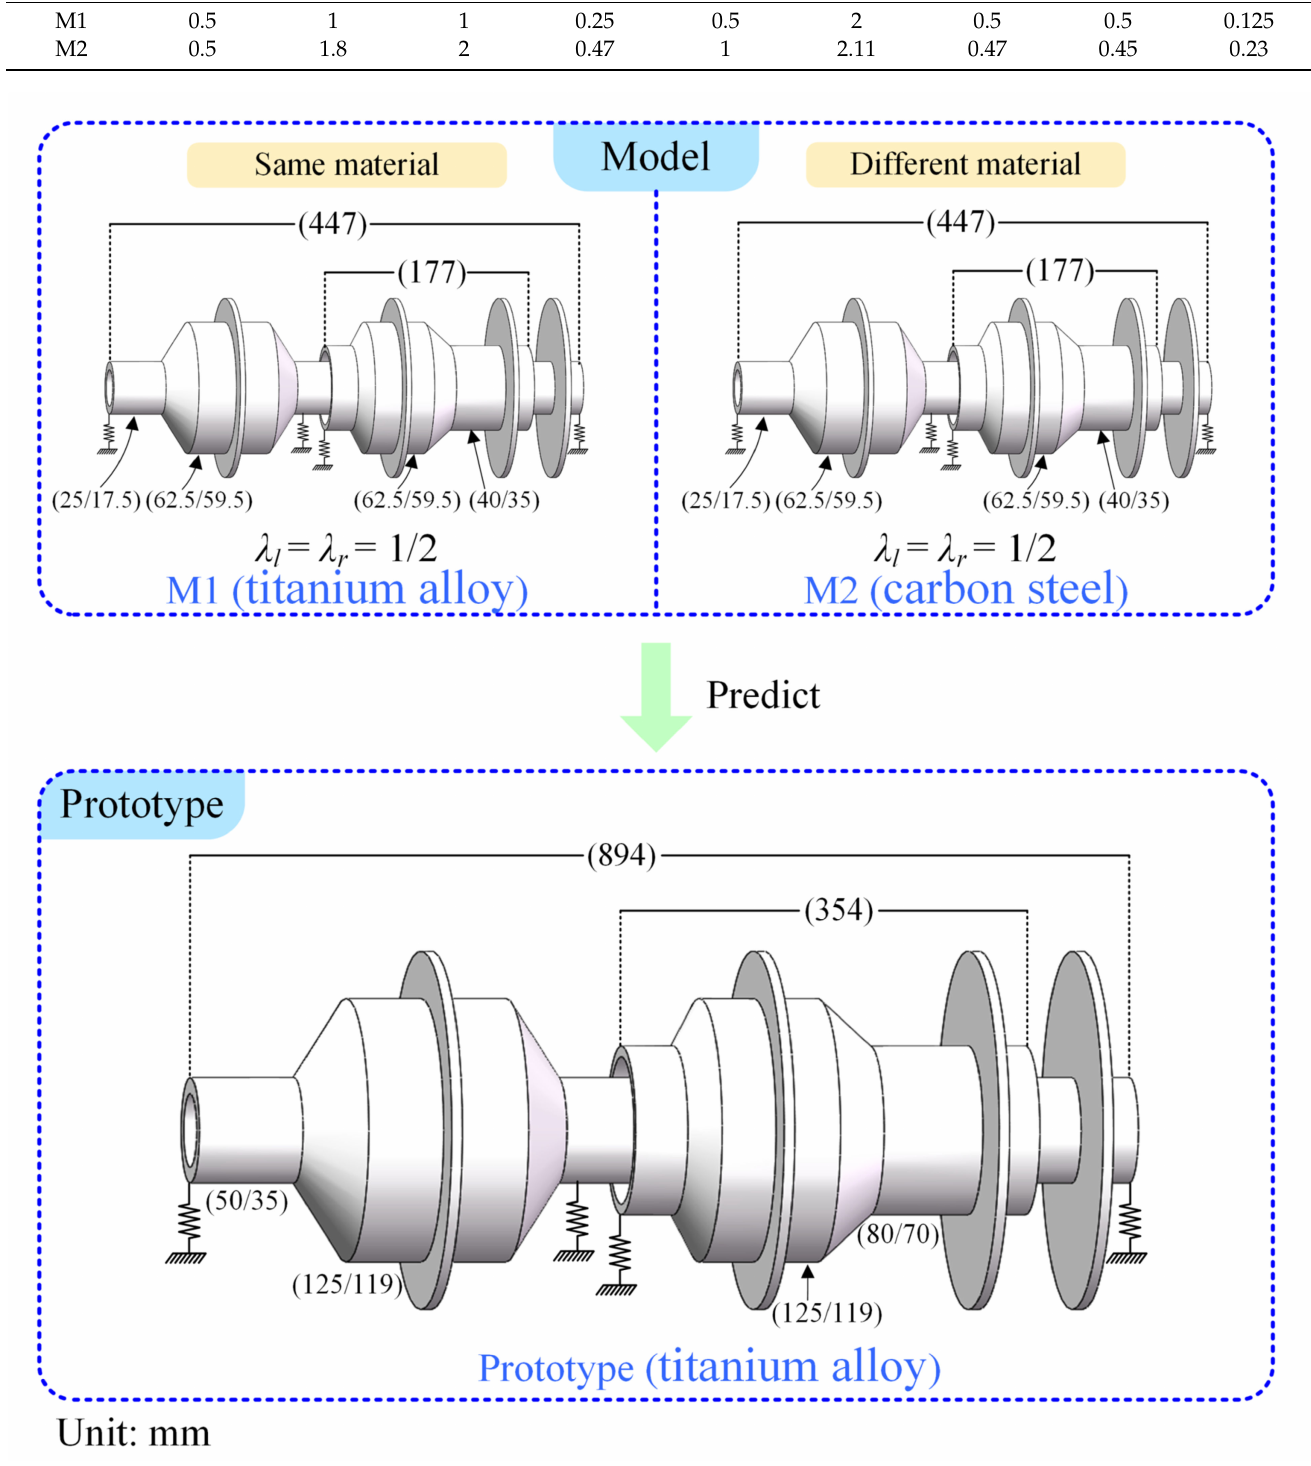
Figure 10. Scheme of models and prototype. Aiming at the working condition and structural characteristics of dual-rotor